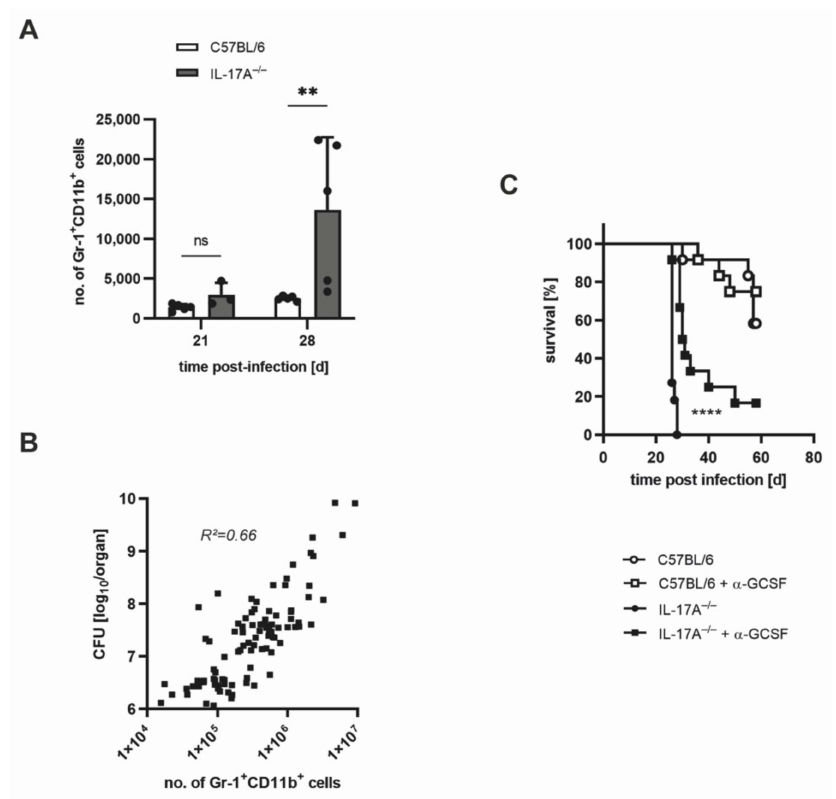
Figure 6. The increased neutrophil infiltration in the lungs of Mtb-infected IL-17A − / − mice con- tributes to their increased susceptibility. ( A ) C57BL/6 and IL-17A − / − mice were infected with >1000 CFU of H37rv Mtb by an aerosol. At different time points of infection, lung cells were pheno- typically analyzed by flow cytometry. Absolute numbers of Gr-1 + CD11b + neutrophils are shown. Data are presented as single dots and as the mean ± SD of 3–5 mice per group from one representative experiment out of two performed. Statistics were calculated using a two-way ANOVA with Bonfer- roni’s post hoc test. Differences between C57BL/6 and IL-17A − / − mice were defined as significant (ns p ≥ 0.05; ** p < 0.01) ( B ) C57BL/6, IL-17A − / − , and IL-17A/F − / − mice were infected with <100 or >1000 CFU of H37rv Mtb via the aerosol route. The correlation between bacterial loads and